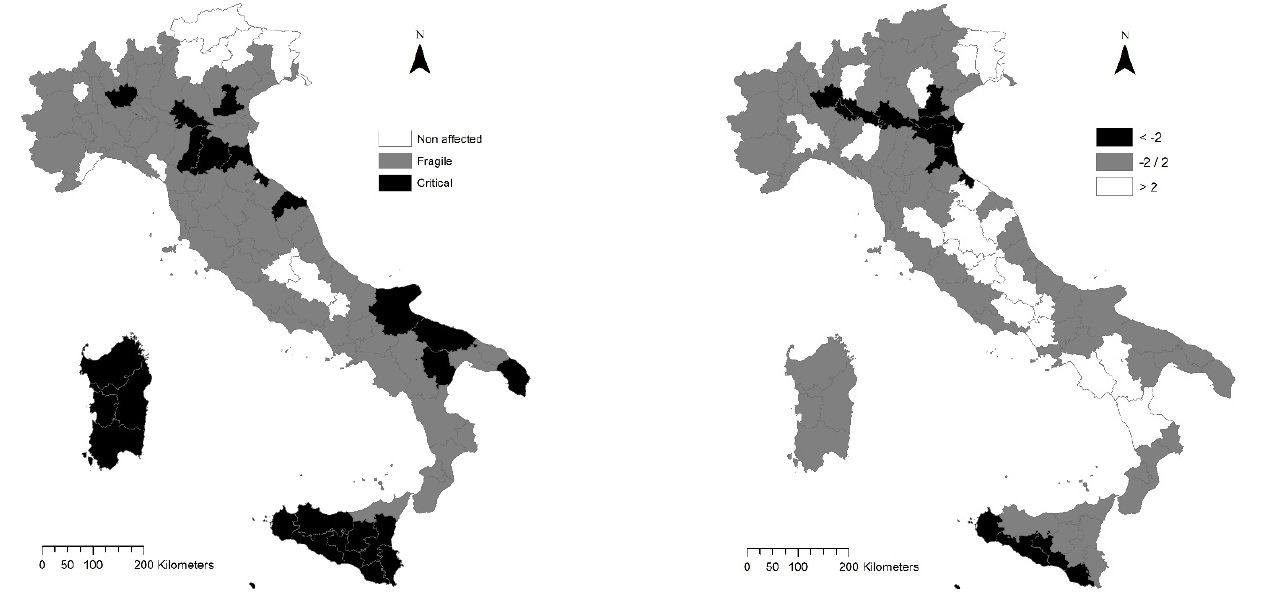
Figure 3. Spatial distribution of non-affected, fragile, and critical land in Italy ( left ) and factor scores (Axis 1, see Table 2) in Italy at the reference year 2010 ( right ).